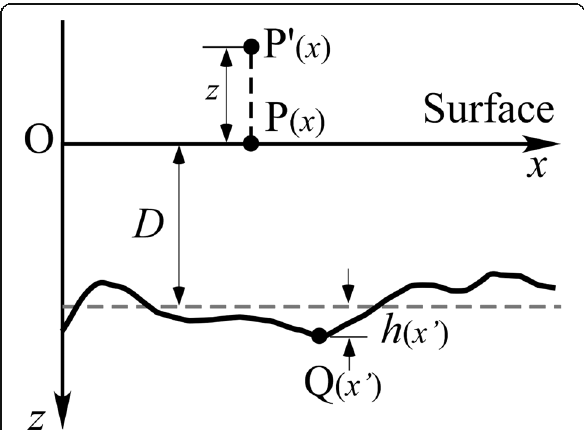
Fig. 2 Model of subsurface structure. A double-layer model consisting of a sedimentary layer and a basement is assumed here. D is the average depth of the stratum boundary, and h ( x ’ ) is the deviation of the boundary from the average. Here, the deviation is assumed to be very small, i.e., h ( x ’ ) <<